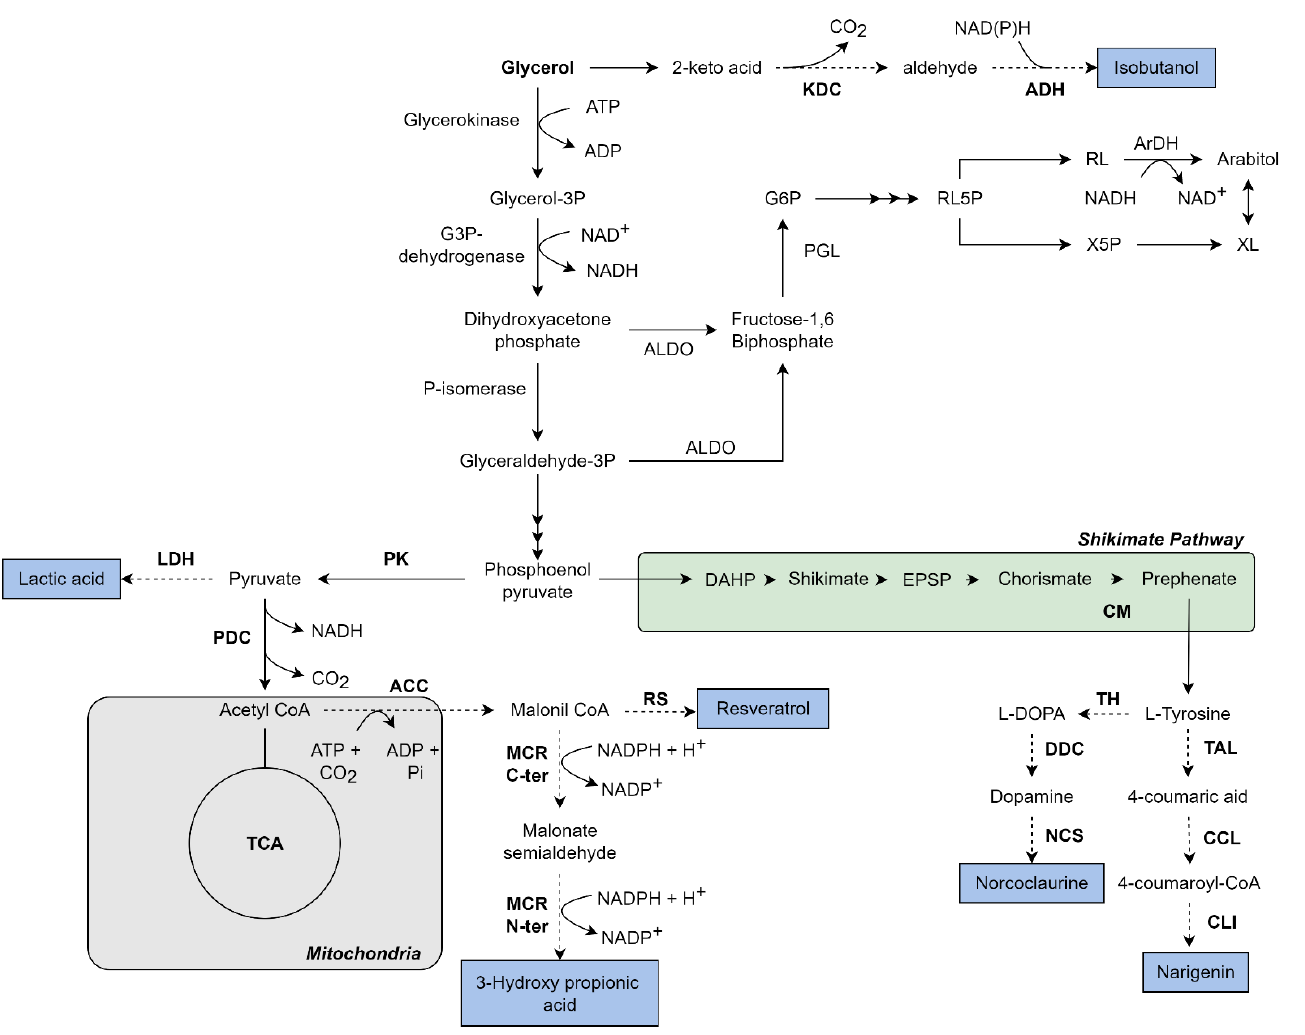
Figure 2. Metabolic pathway to glycerol assimilation and production of a variety of chemicals by K. phaffii. Black arrows represent the native glycerol metabolism; dotted arrows represent an overex- pressed/heterologous pathway. Bold enzyme names represent an overexpressed/heterologous en- zyme, and the blue boxes represent the final product. Some reactions are summarized for better com- prehension. Additionally, not all cofactors are represented in the figure. G6P: Glucose-6-phosphate; RL5P: Ribulose-5-phosphate; RL: Ribulose; X5P: Xylulose-5-phosphate; XL: Xylulose; DHAP: 3- deoxy-D-arabinoheptulosonate-7-phosphate; EPSP: 5-O-(1-carboxyvinyl)-3-phosphoshikimate;